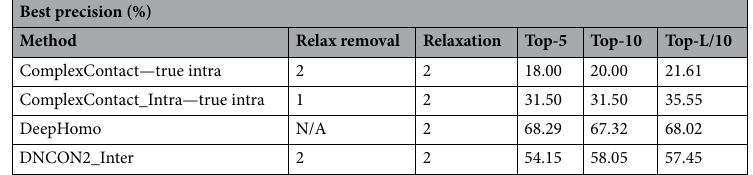
Table 1. Comparison between the best precisions (%) of interchain contacts predicted by ComplexContact, ComplexContact_Intra, DeepHomo, and DNCON2_Inter on 40 randomly sampled proteins from the homodimer dataset. Half of the samples had zero Top-5 and Top-10 precisions as predicted by DNCON2_ Inter. For the ComplexContact and ComplexContact_Intra, the evaluation is done after removing the true contacts from the predicted contacts at relax removals 0, 1, and 2. The best precisions for all methods are obtained for relaxation = 2.